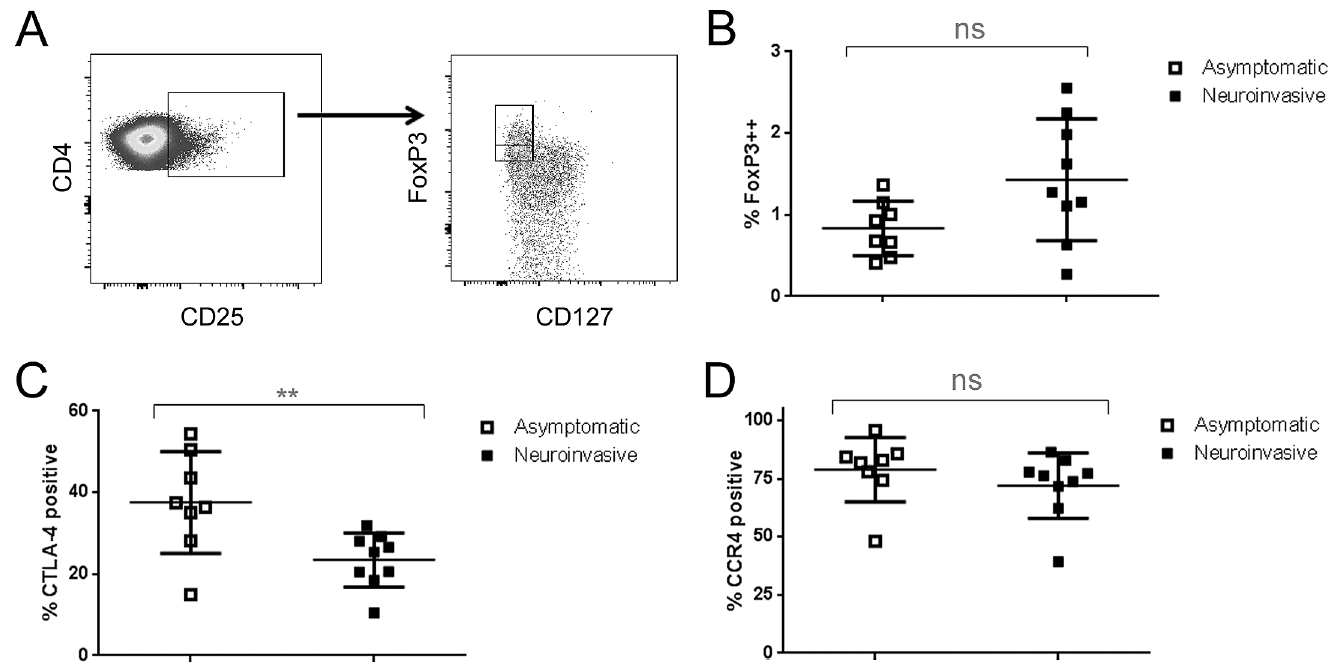
Fig 8. Altered Treg phenotype in subjects with neuroinvasive WNV. A) CD4+ Tregs were evaluated in PBMC samples from 9 subjects with neuroinvasive infection or 8 subjects with asymptomatic WNV by gating on CD25+CD4+ T cells and subsequently gating on CD127lowFoxP3++ T cells (designated by the upper left rectangle). B) Each symbol represents the overall percentage of Treg (CD4+CD25+CD127lowFoxP3++ T cells) within the PBMC of a single WNV infected subject. The percentage of CD4+ Tregs was not significantly different between subjects with neuroinvasive or asymptomatic WNV. C) Each symbol represents the percentage of Treg that were CTLA-4 positive for a single WNV infected subject. Subjects with neuroinvasive WNV had a significantly lower percentage of CTLA-4 positive Tregs (p = 0.0097). D) Each symbol represents the percentage of Treg that were CCR4 positive for a single WNV infected subject. The percentage of Treg that were CCR4+ was not significantly different between subjects with neuroinvasive or asymptomatic WNV.